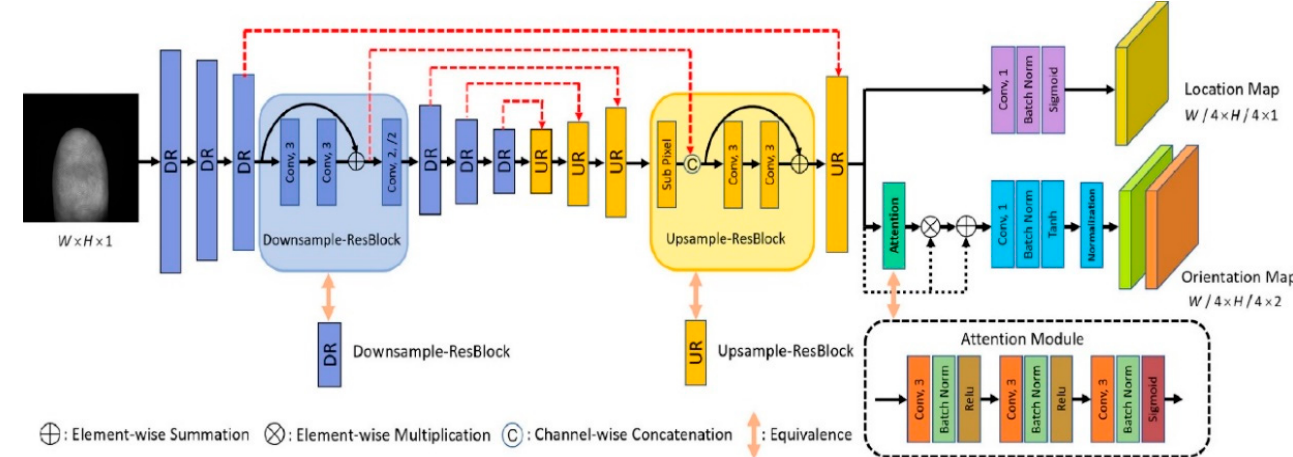
Figure 8. An architecture of multi-task deep convolutional networks [79].